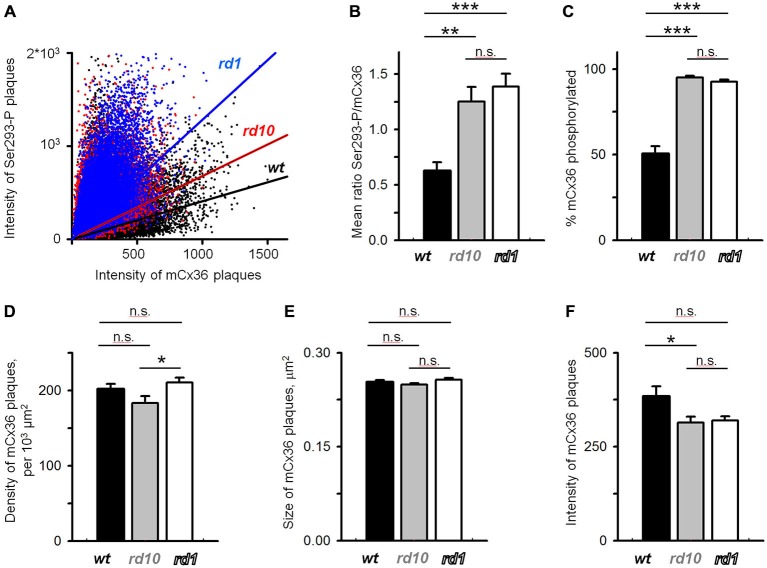
Quantification of Cx36 gap junctions in AII amacrine cells in wt, rd10 and rd1 retinas. (A) Cx36 was heterogeneously phosphorylated in the retinas of all mouse models, which is reflected by a low correlation between the intensity of Cx36 and its phosphorylation (wt r2 = 0.096; rd10 r2 = 0.131; rd1 r2 = 0.299). (B) Relative phosphorylation of Cx36, extracted from the data in (A), shows overall more phosphorylation in retina of RD models. (C) The absolute amount of phosphorylation, reflected by the percentage of Cx36 plaques that show detectable Ser293-P labeling, was also elevated in RD retinas. (D,E) The density of Cx36-positive plaques (D), their size (E), and intensity of mCx36 labeling (F) were not significantly altered in RD models. The data are presented as average; error bars are SEM. All significances are based on ANOVA test, where ***p < 0.001, **0.001 < p < 0.01, *0.01 < p < 0.05, n.s. p > 0.05.